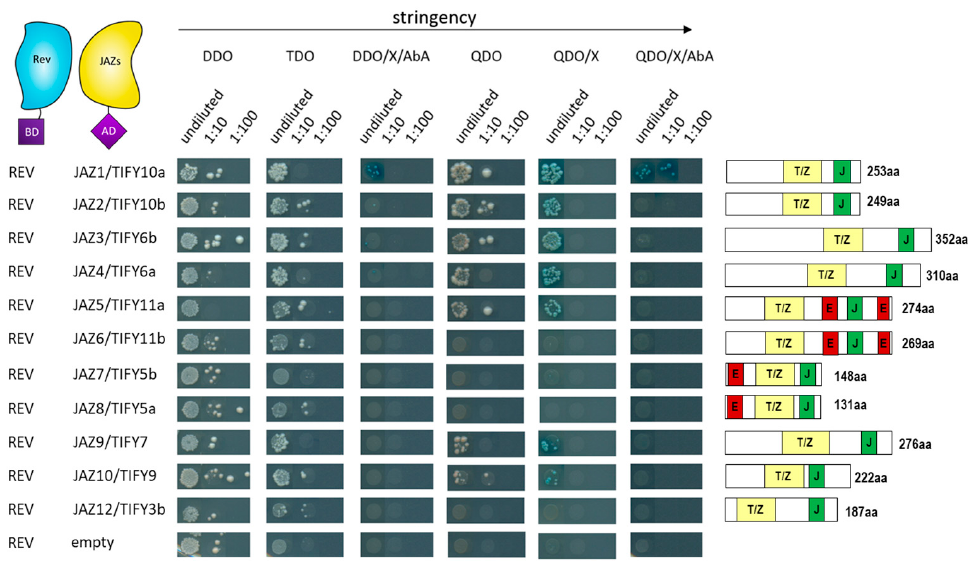
Figure 9. Yeast two-hybrid interactions between REV and JAZ proteins . Representative yeast two-hybrid assay between Gal4-BD-REV and GAL4-AD-JAZ fusion proteins. A serial 1:10 dilution of each transformed yeast was spotted onto control (DDO) and different protein–protein interaction-selective media with increasing stringency. Blue boxes indicate interactions. Protein domains of the different JAZ proteins are indicated on the right. The yellow box represents the TIFY/ZIM domain. The green box represents the Jas domain. The red box indicates the repressing EAR domain.